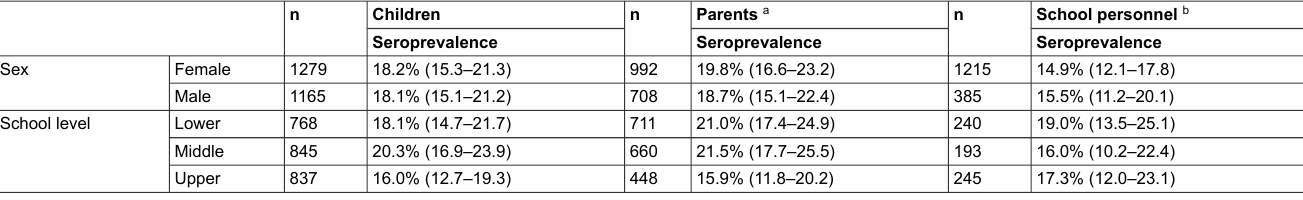
Table S2: Seroprevalence with 95% confidence interval [number of participants] in children, parents and school personnel based on sex and school level in March-April 2021. n